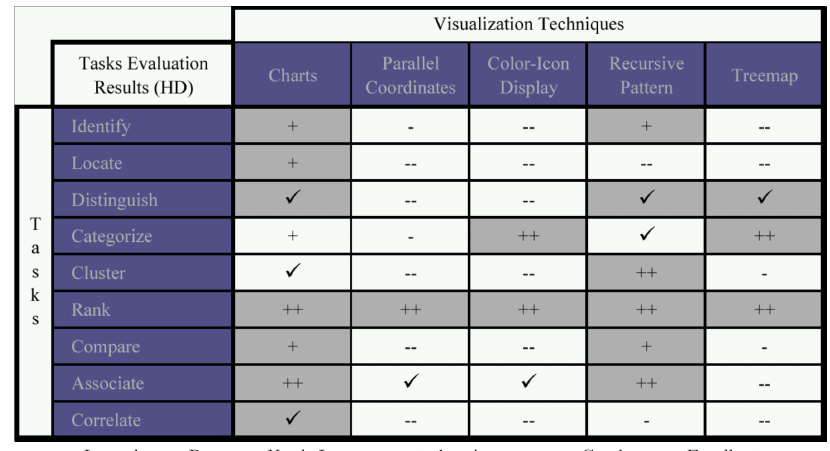
Figure 13. The results table for the task evaluation. The “Charts” category scores highly, whereas the “Parallel Coordinates” scores relatively poorly. Evaluation criteria such as “Correlations” only scores highly in the “Charts” category. This shows the limitations of more elaborate visualisations, and the value of simplicity. Image courtesy of Merino et al.